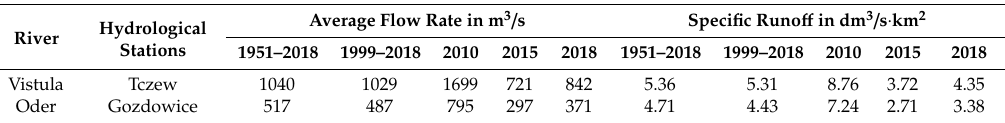
Table 2. Characteristics of the Vistula and the Oder runo ff (based on Institute of Meteorology and Water Management—National Research Institute data).